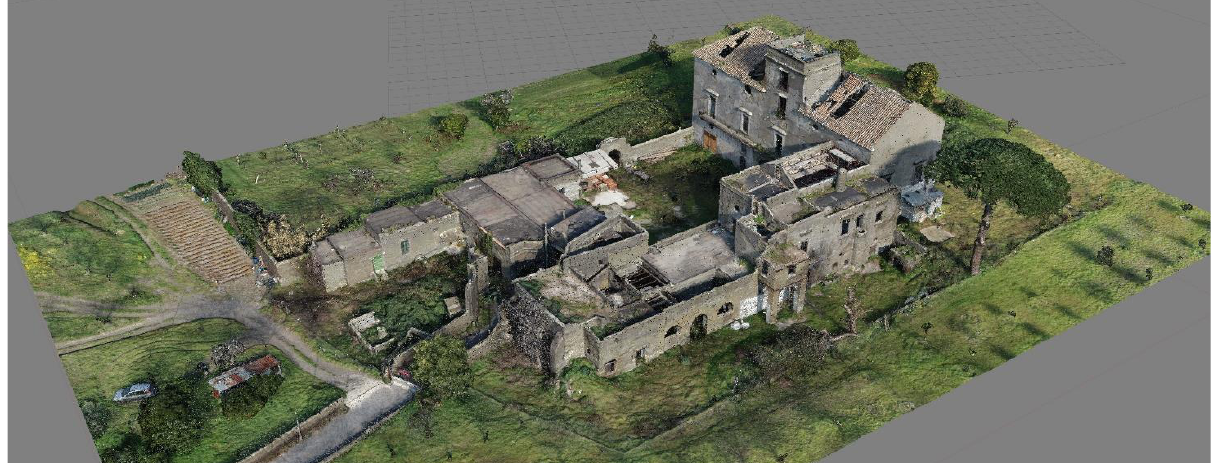
Figure 5. Image of 3D survey obtained by photomodeling being processed (M. Facchini,